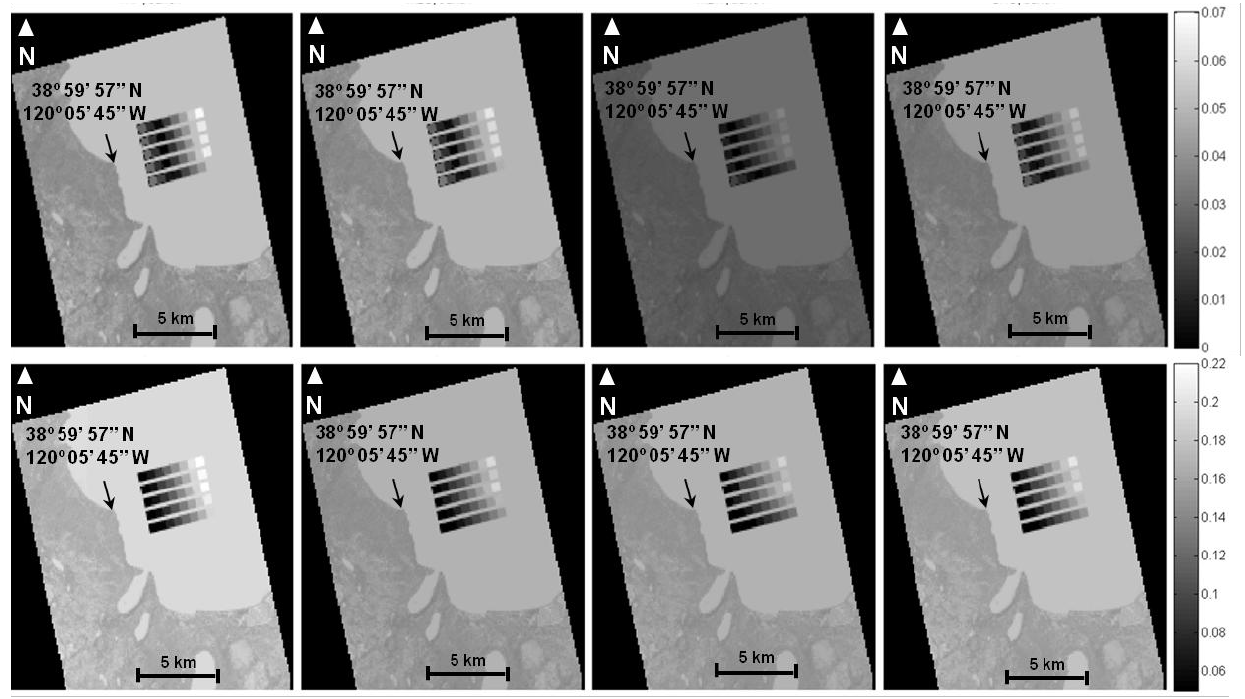
Figure 9. Percent differences between the two mean class shapes in the 10.8 μm channel ( top row) and 12.0 μm channel ( bottom row). From left to right are tropical, mid-latitude summer, mid-latitude winter, and sub-arctic summer atmospheres. Maximum scene differences between the two band shapes are approximately 0.1% and a 0.2% for the 10.8 μm and 12.0 μm channel,